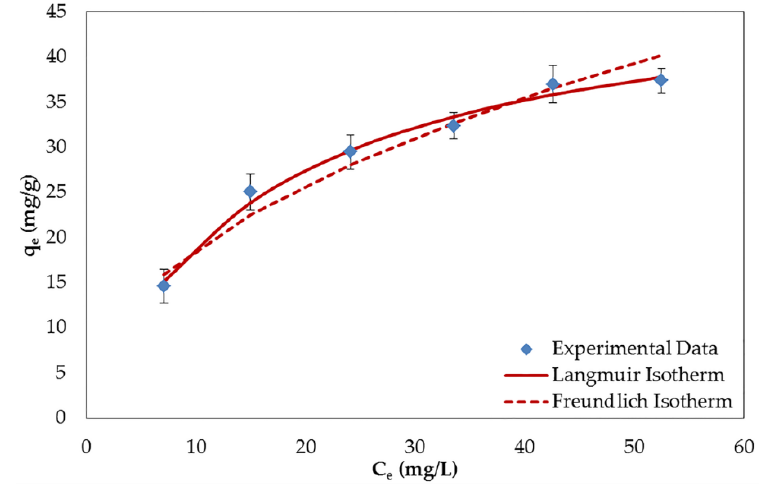
Figure 7. Adsorption isotherms of BPA on GO at a temperature of 298 K. C e : the concentration of BPA at equilibrium (mg/L).